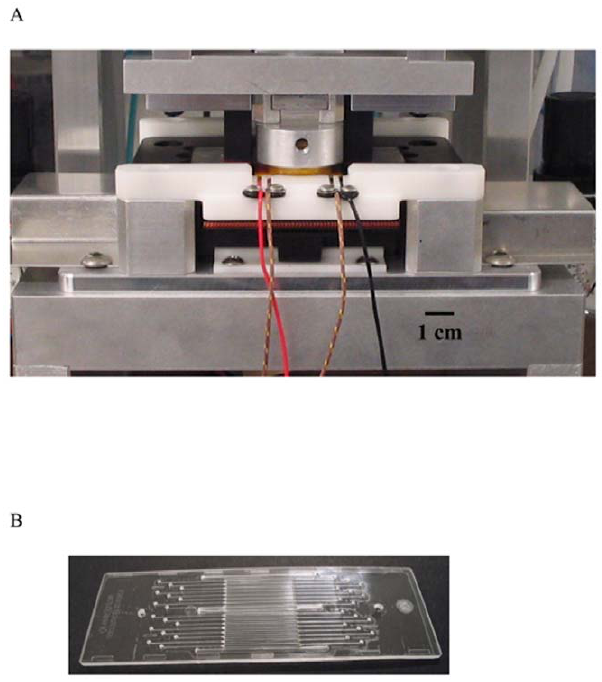
Figure 1. Microfluidic thermal cycling for PCR and Sanger sequencing. A) Rapid, Peltier-based thermal cycler; B) 16 sample microfluidic biochip (dimension 25 6 75 mm).